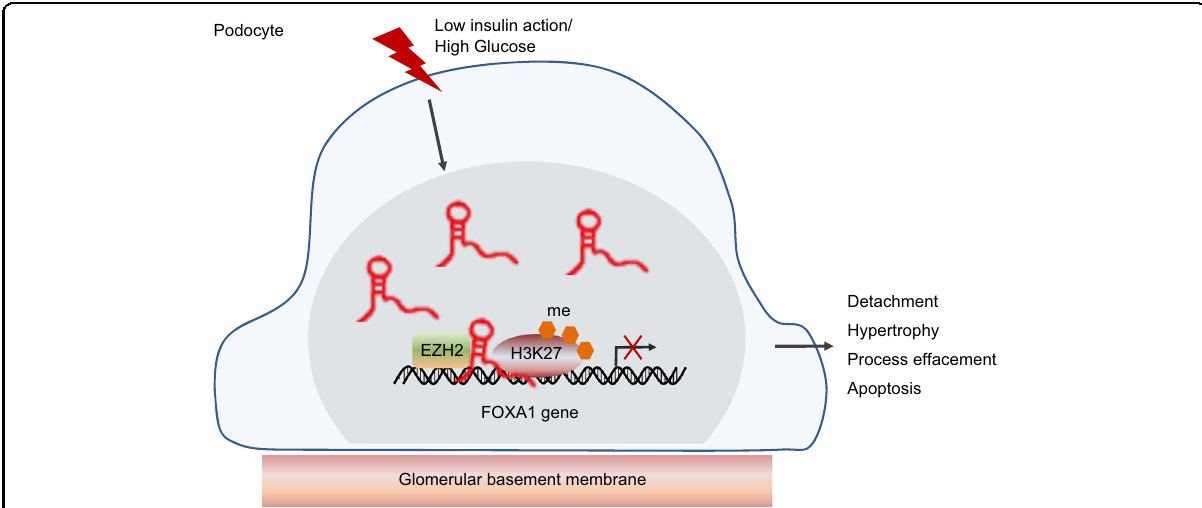
Fig. 6 The mechanism map illustrating the regulatory role of lncRNA PVT1 in the damage of podocytes by inhibiting FOXA1. PVT1 can promote the recruitment of H3K27me3 in the FOXA1 promoter region by recruiting EZH2 to inhibit the expression of FOXA1, thereby promoting the damage and apoptosis of podocytes in diabetic nephropathy. LncRNA PVT1, long noncoding RNA; PVT1, plasmacytoma variant translocation 1; FOXA1, forkhead box A1; EZH2, enhancer of zeste homolog 2; H3K27me3, histone 3 lysine 27